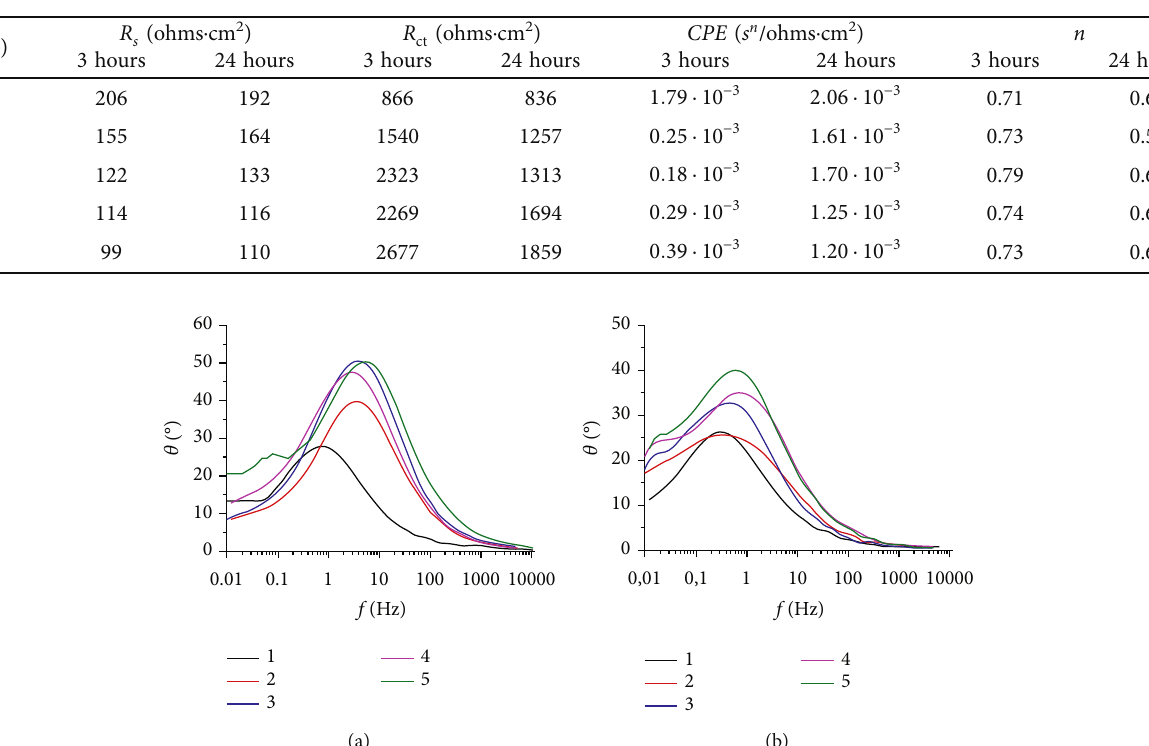
Figure 5: Frequency dependencies of phase angle of 09G2S steel after 3 hours (a) and 24 hours (b) of exposure to a 0.1% NaCl solution with a concentration of sodium citrate of (1) 0g/l, (2) 1.0g/l, (3) 1.5g/l, (4) 2.0 g/l, and (5)